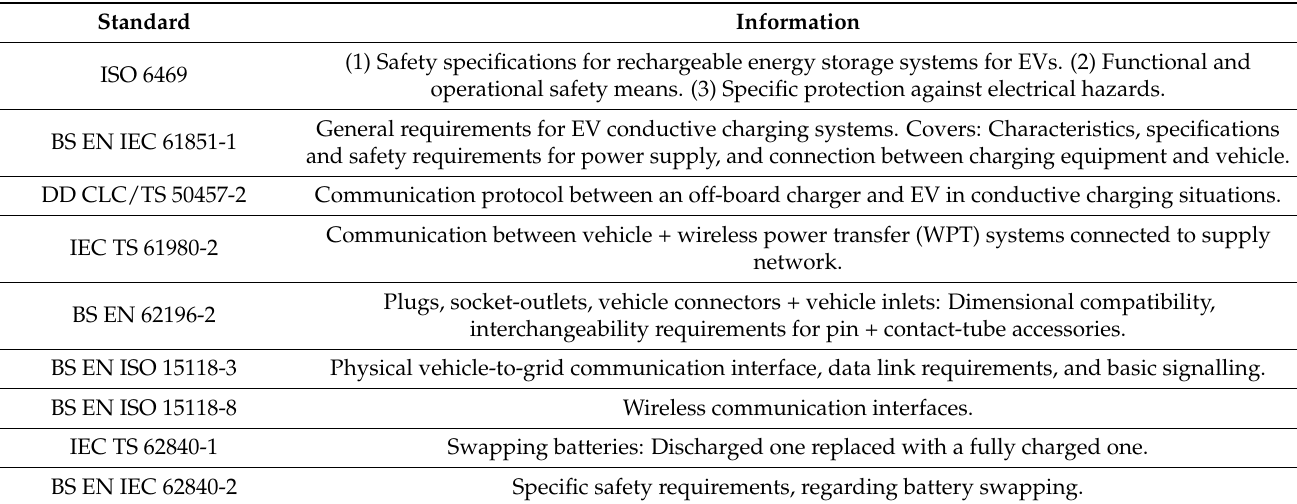
Table 1. Standards provided by the BSI for newly manufactured EVs [61].